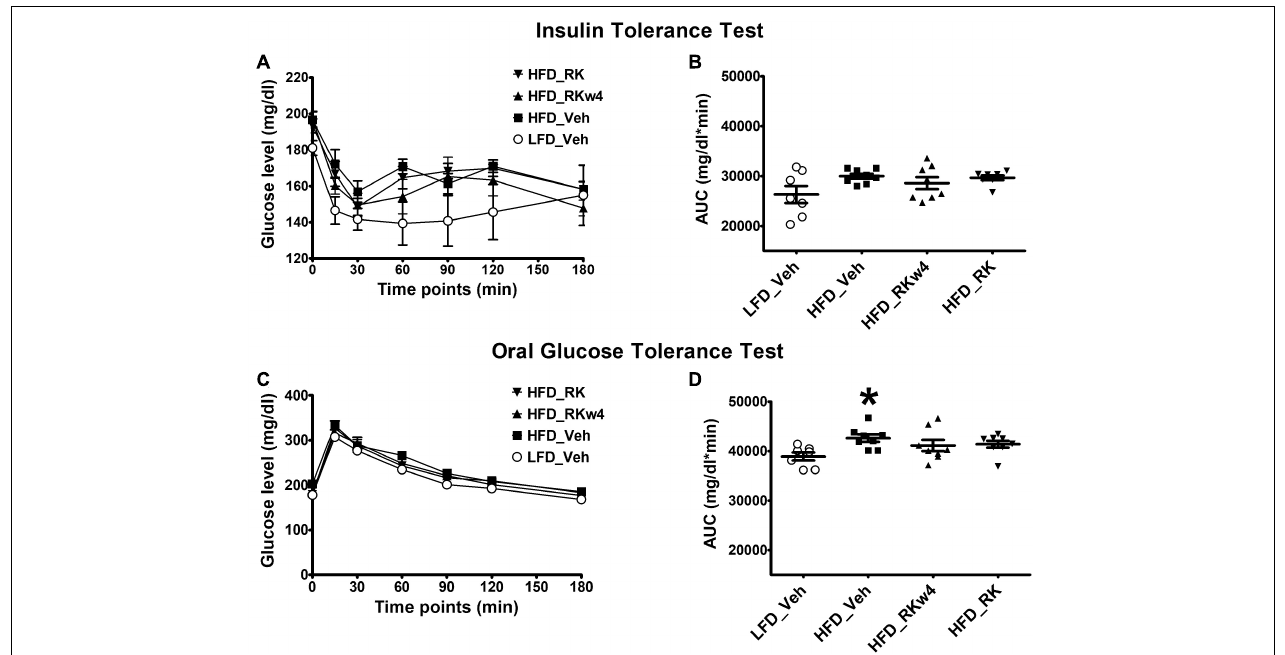
FIGURE 4 | Insulin tolerance test (ITT) and glucose tolerance test (OGTT) on Weeks 9 and 10, respectively, of daily oral gavage of RK (200 mg/kg) or vehicle (Veh) in mice. Groups were mice that were fed a low-fat diet daily oral gavage with vehicle (LFD_Veh), high-fat diet oral gavage with vehicle (HFD_Veh), oral RK dosing initiated at 4 weeks of HFD (HFD_RKw4), and HFD and oral gavage RK administered (HFD_RK). RK had no effect on glucose response in the ITT (A,B) , but normalized responses in the OGTT (C,D) . Data are represented as mean ± SEM. * p < 0.05 vs. LFD_Veh. Repeated measures with ANOVA for glucose response analysis; one way ANOVA for AUC followed by Newman Keuls post hoc testing ( n = 7 for LFD_Veh; n = 8 per HFD group).